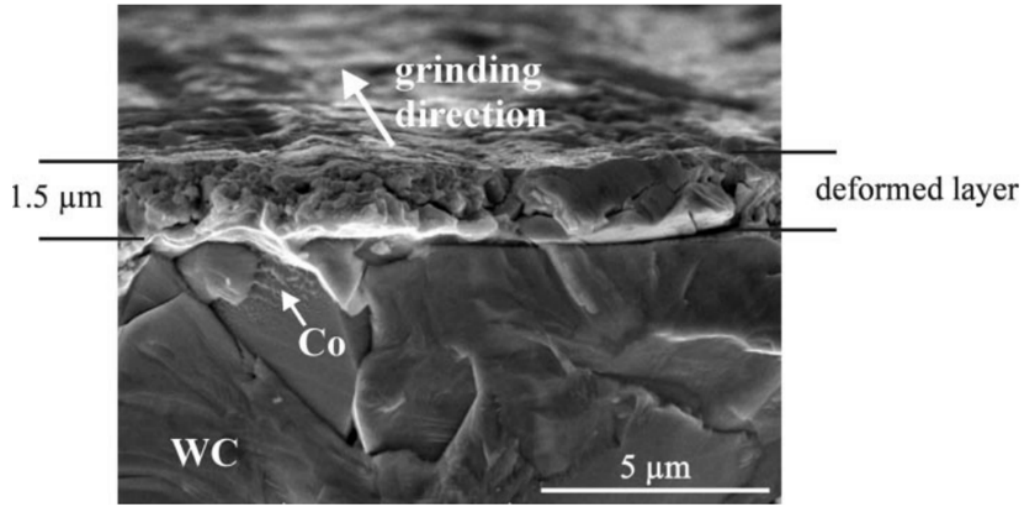
Figure 12. Deformed layer of WC–10 wt.% Co following diamond wheel grinding [18]. Reprinted with permission from [18]; 2001 Elsevier.